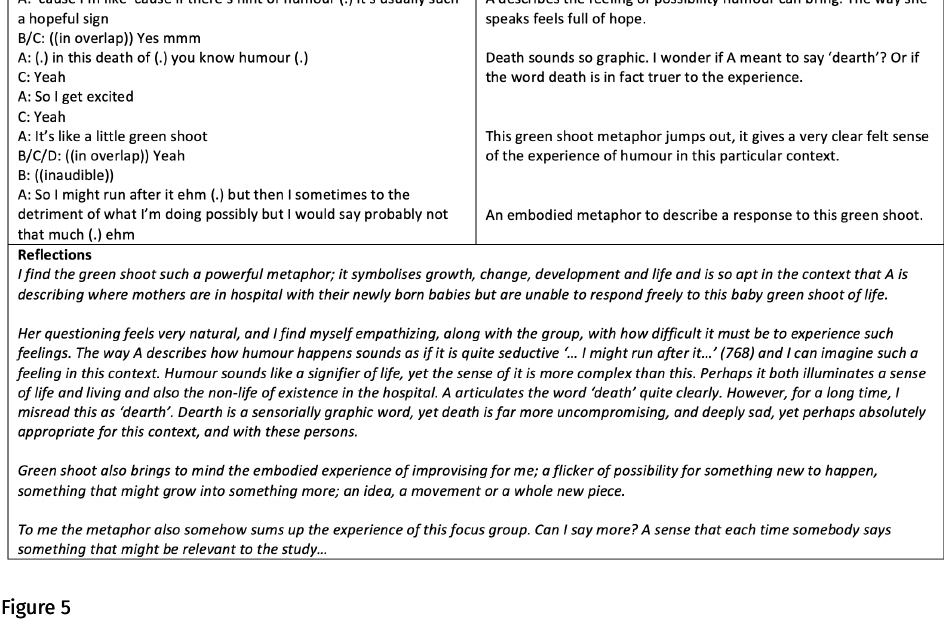
FFigigururee 55 Excerpt of reflexive analysis from FG1, passage